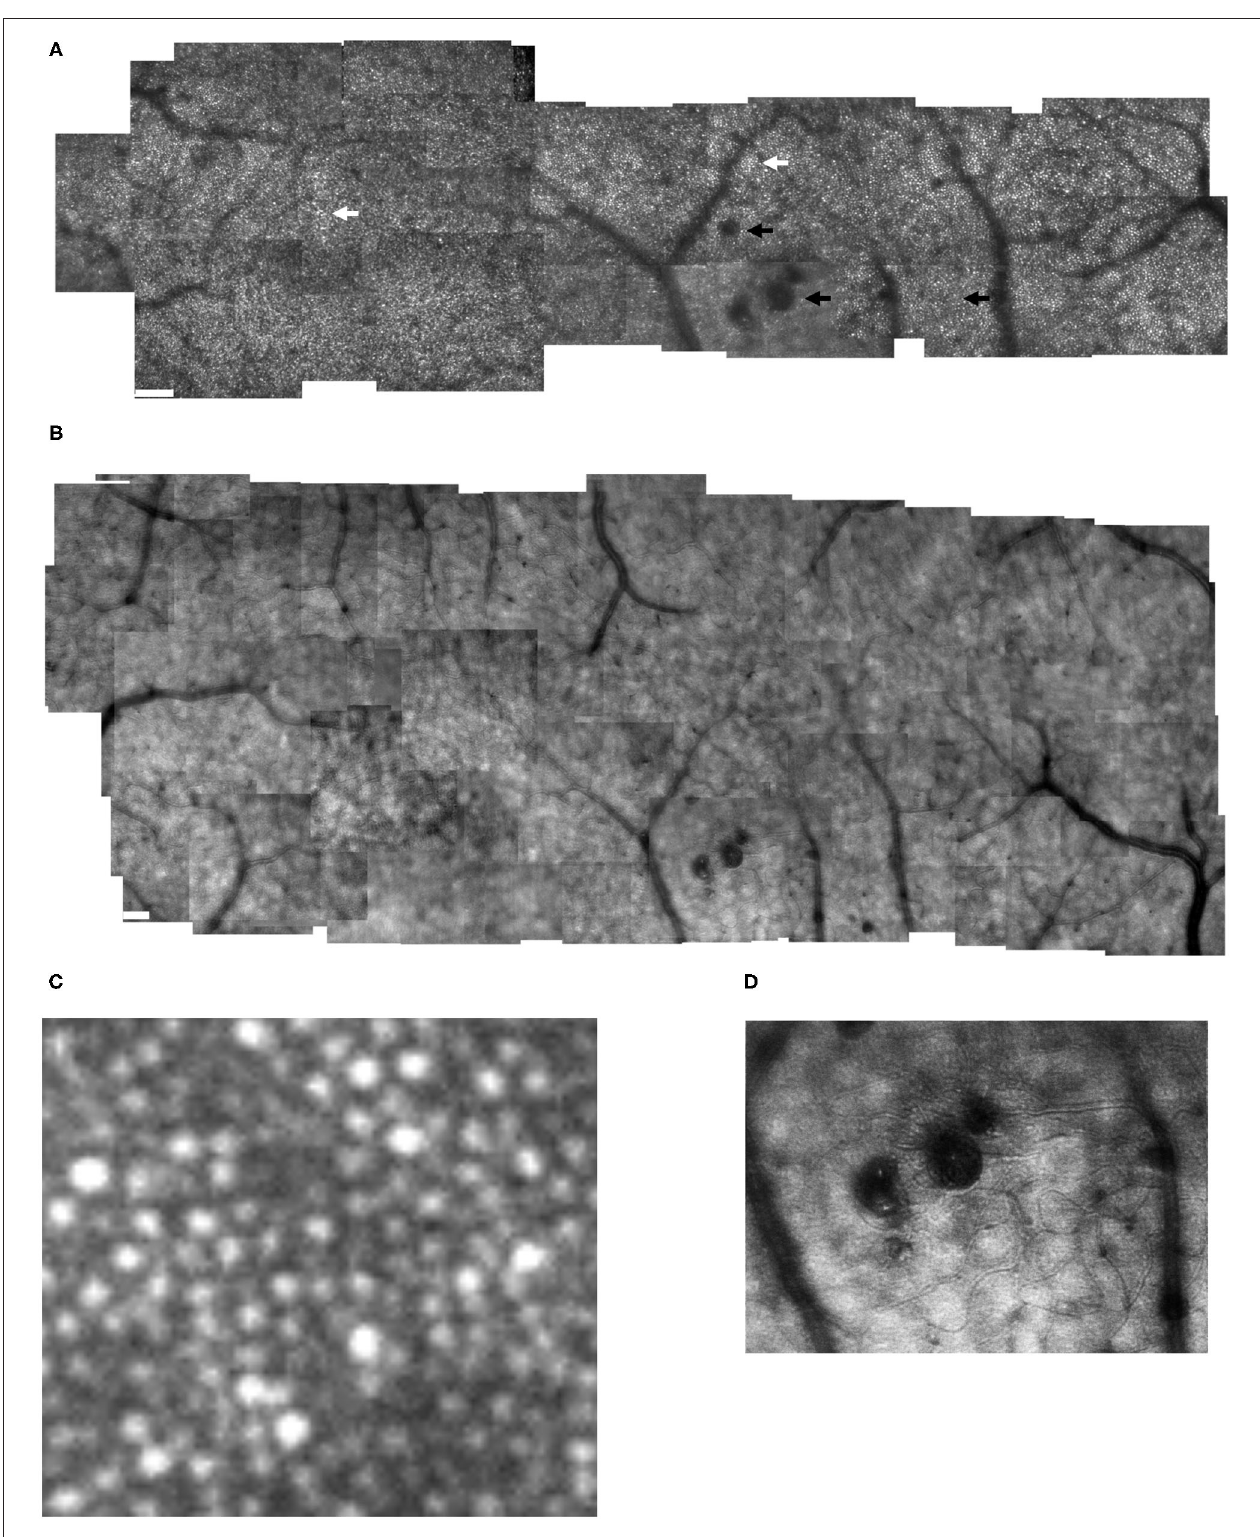
FIGURE 2 | Cone distribution for a 59 yr old female diabetic subject, collected with the confocal mode of the AOSLO (A) , shown in a montage of cone images with the foveal region on the left. The retinal microvasculature layer montage (B) shows a strong response to ischemia, with numerous retinal vascular changes